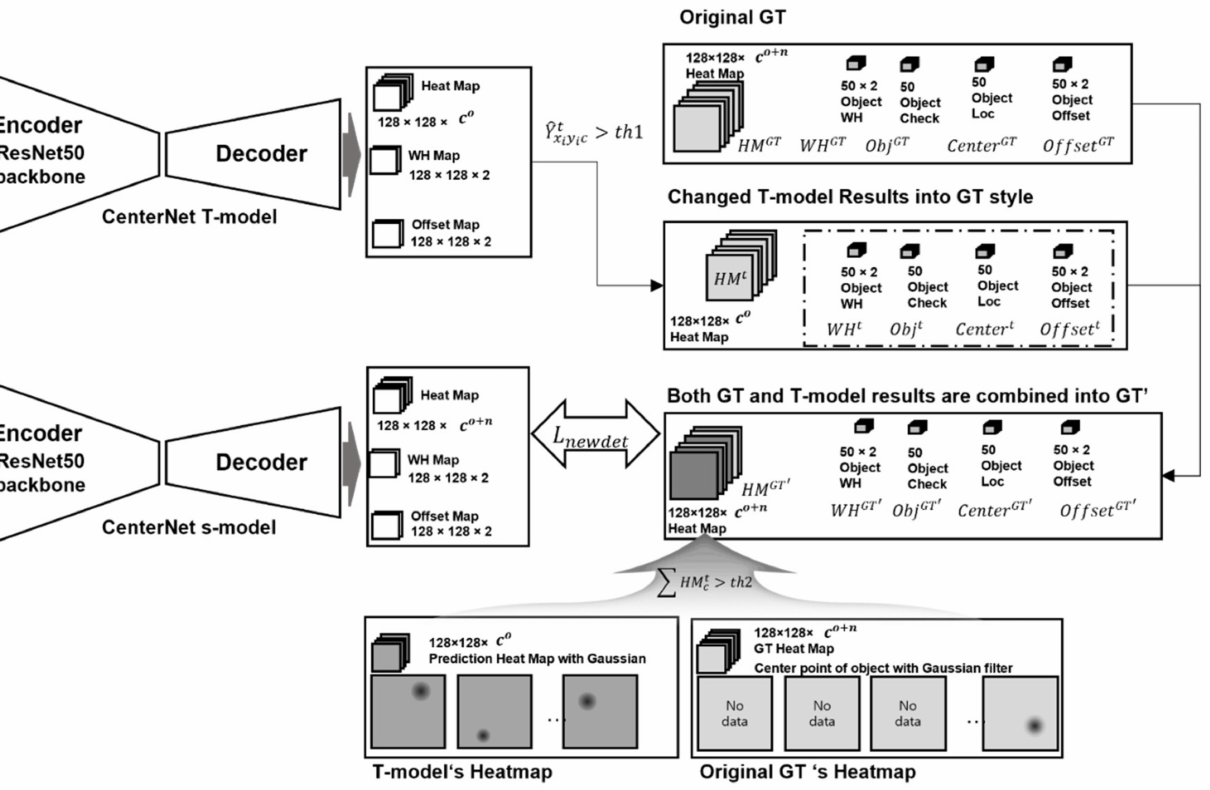
Figure 2. The proposed t-model predictive distillation